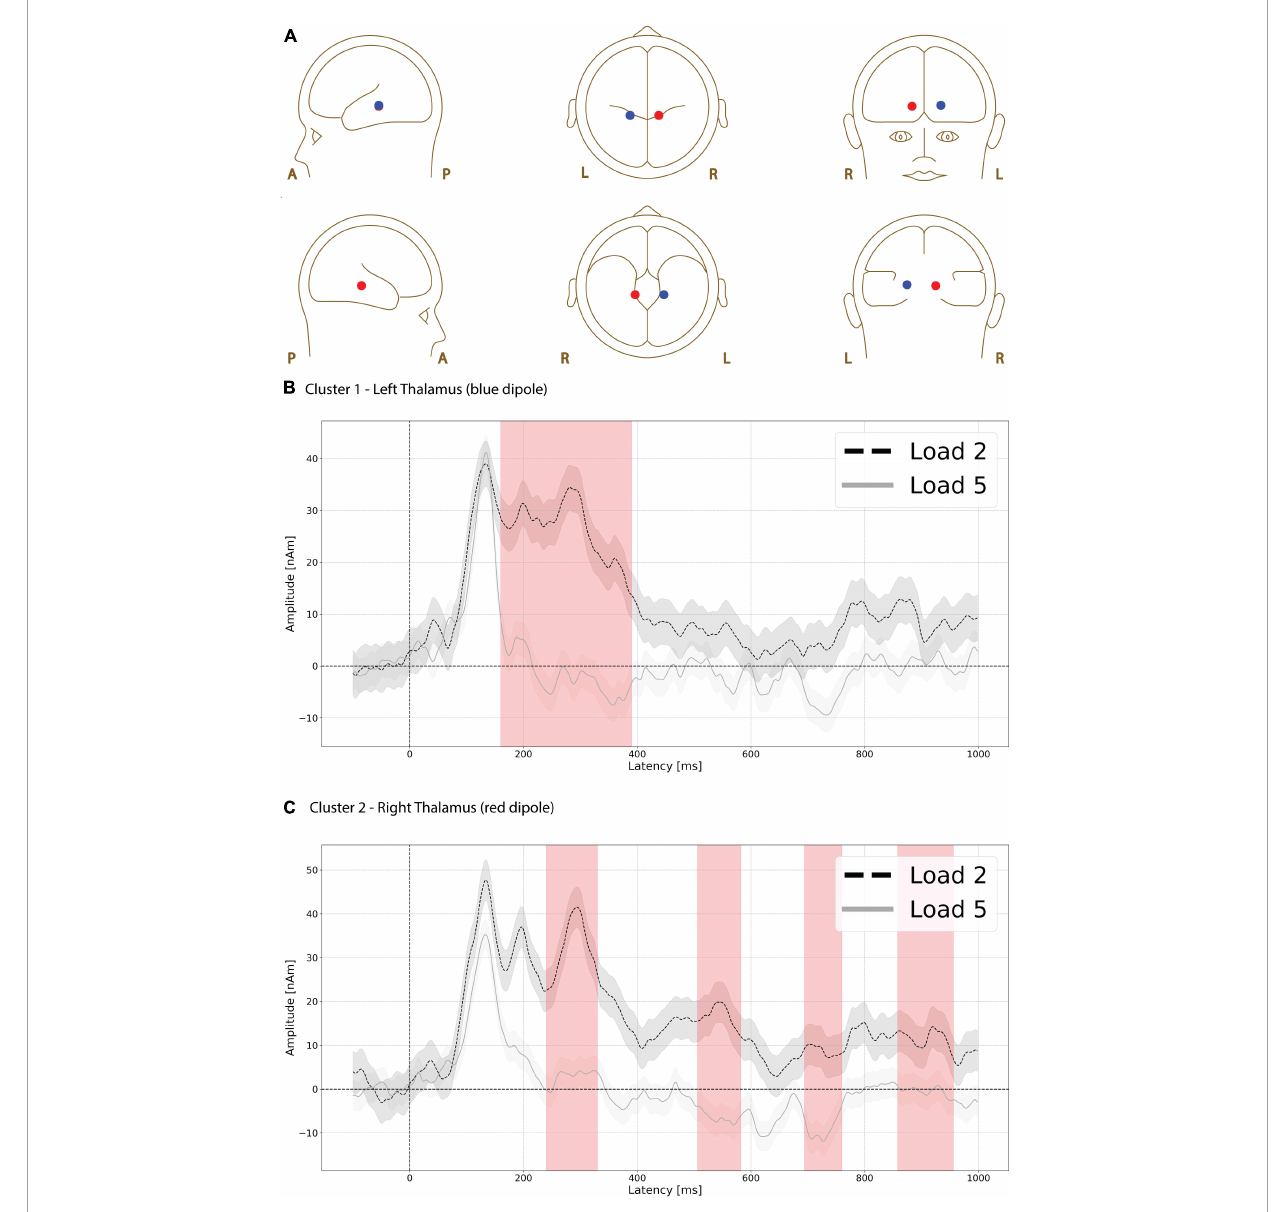
FIGURE5 Functional magnetic resonance imaging (fMRI)-weighted thalamic source group EEG waveforms during the delay period. Head plot of asymmetric dipole clusters located in thalamus in left (blue) and right (red) hemispheres (A) . Cluster 1 in left thalamus (blue dipole) showed evoked responses that were significantly higher ( p = 0.003) in amplitude during the low compared to high load delay period (red shading) between 160 and 390 ms (B) . Cluster 2 in right thalamus also showed greater amplitude during low compared to high load in four separate time windows (C) : the earliest window of significant difference was between 240 and 330 ms ( p = 0.022, first red vertical shade), followed by an interval between 506 and 582 ms ( p = 0.034 second red vertical shade), followed by 694–760 ms ( p = 0.046, third red vertical shade), and finally 858–956 ms ( p = 0.021, fourth red vertical shade). Lines are mean amplitude with shaded error bars representing ± 95% confidence